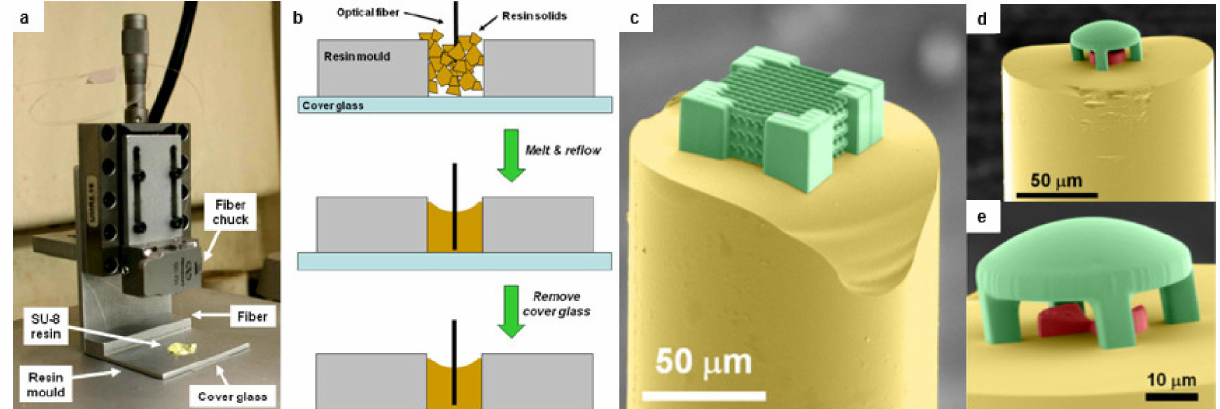
Figure 9. Fiber-bound SU-8 photonic devices: ( a ) Optical fiber and SU-8 resin sample mount setup; ( b ) Schematic illustration of the melt-reflow process to create SU-8 mount; False-color SEM images of ( c ) a woodpile face-centered tetragonal photonic crystal and ( d , e ) a compound micro-optic system consisting of a suspended plano-convex lens and a smaller plano-concave lens in contact with the fiber end-face, both fabricated on the end of an optical fiber by MPL in SU-8 resin. Reprinted with permission from [50] © The Optical